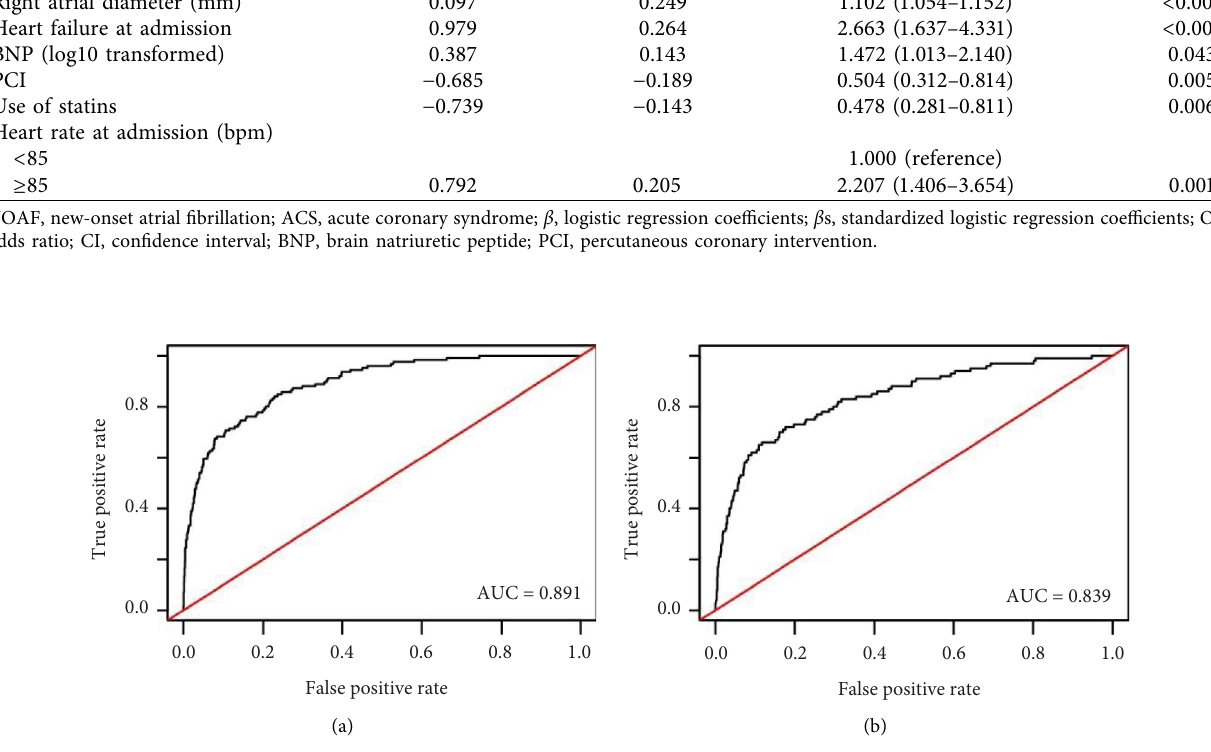
Figure 1: Receiver operating characteristic (ROC) curve for models in predicting NOAF in ACS patients. (a) ROC curve for the model in the training cohort; (b) the ROC curve for the model in the validation cohort. AUC, area under the curve.